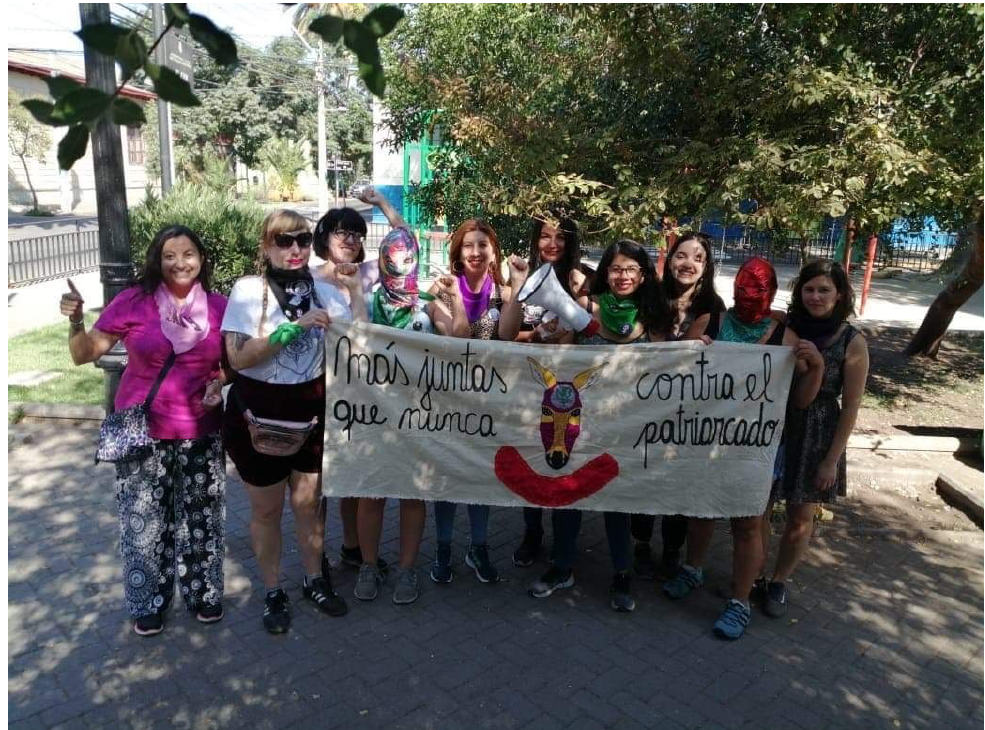
8 March 2020 – Plaza Huemul – feminist members of the Huemul Assembly before their participation in the 8 March General Feminist Strike. The banner reads: ‘More together than ever against patriarchy’ (Source: Paula Andrea Moncada Hern á